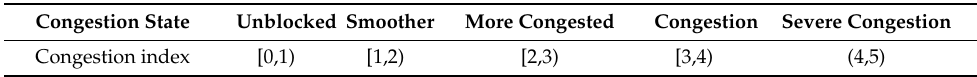
Table 5. Correspondence between congestion index and congestion